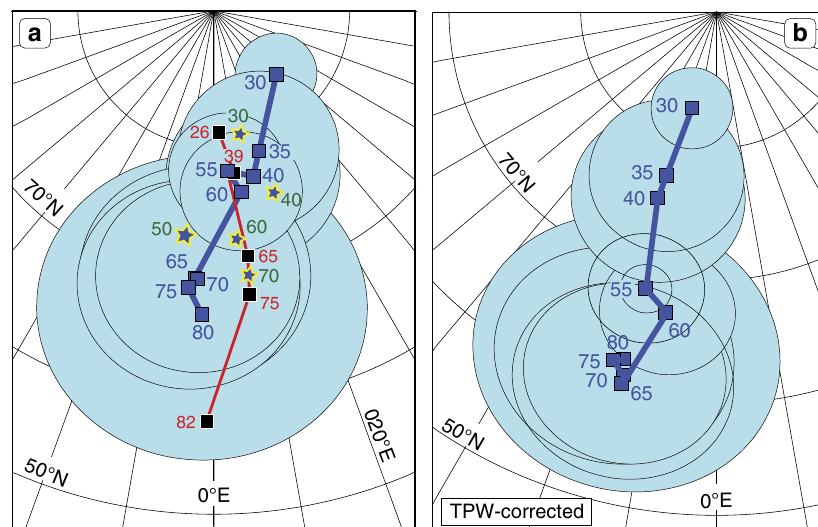
Figure 8 | Pacific apparent polar wander. ( a ) A revised APW path for the Pacific plate (Table 1) is shown by blue squares with a blue line and A 95 ovals (light blue shading). Black squares connected with red lines is a Pacific APW path by Gordon and Van der Voo 33 . Blue/yellow star symbols are Pacific running mean poles (time window poles, all data types) listed in Beaman et al. 25 . Both data sets are shown without confidence ovals for clarity. ( b ) TPW- corrected Pacific path (see Methods). Numbers show the ages Myrs ± 5Myr (that is, computed with a 10Myr running mean). See Table 1 for details. Table 1 | Pacific apparent polar wander path.